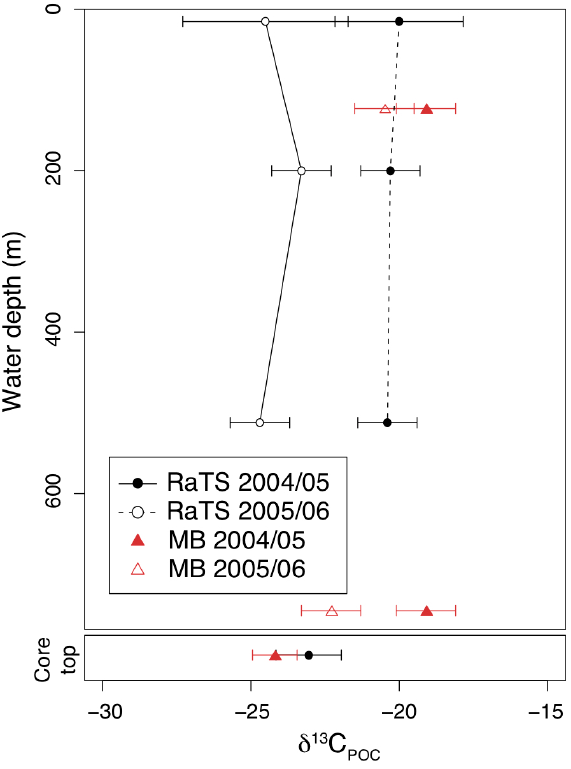
Fig. 11. Depth profiles of seasonal average δ 13 C POC in Ryder Bay (RaTS; circles) and Marguerite Bay (MB; triangles) for 2004/05 (filled symbols) and 2005/06 (open symbols). The uppermost point in each Ryder Bay profile is the seasonal concentration-weighted average suspended particle δ 13 C POC value from surface water sam- ples, with error bars representing 1* σ . All other points in the upper panel represent seasonal flux-weighted average δ 13 C POC in sediment traps, with errors of 1.0‰ associated with formaldehyde preservation (Mincks et al., 2008) as this vastly exceeds analytical error. The lower panel shows δ 13 C POC of core-top sediments. Er- ror bars for Ryder Bay core-top δ 13 C POC represents 1* σ . For Mar- guerite Bay core-top, error bars represent analytical error of